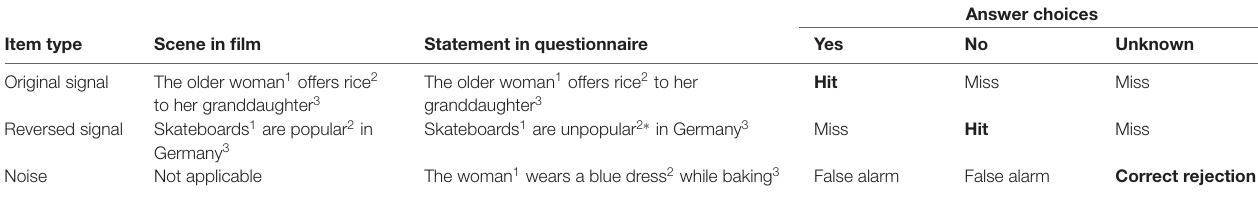
TABLE 1 | Scoring matrix for hits and false alarms used in the primary analysis.